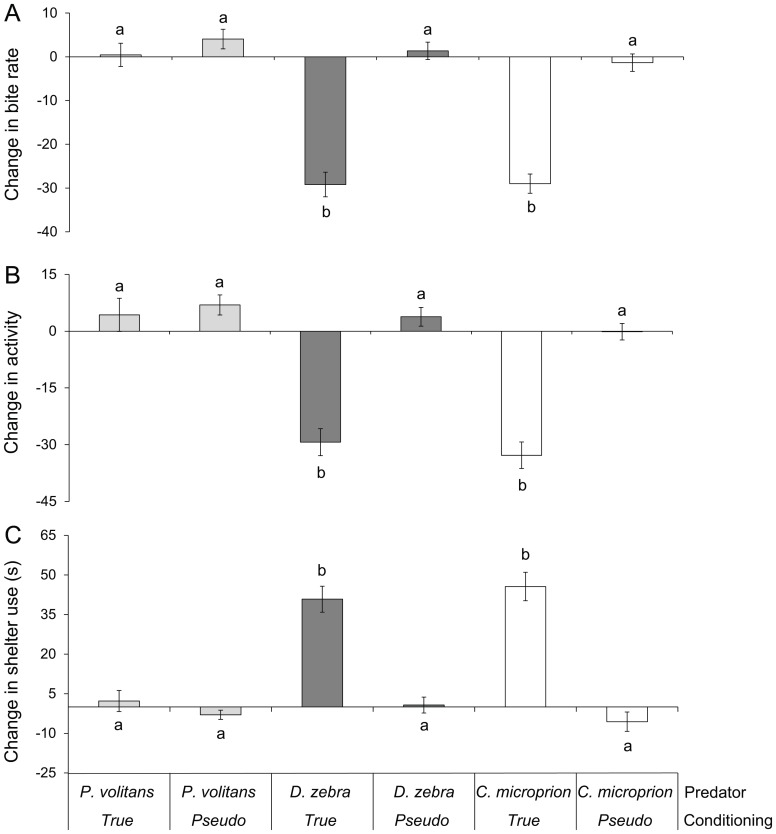
Behavioural responses of inexperienced and experienced juvenile Chromis viridis to olfactory cues of three different predators.Experienced prey fed less (A), lowered activity rates (B) and increased shelter use (C) when exposed to olfactory cues of Dendrochirus zebra and Cephalopholis microprion (N = 16–19). Letters indicate significant groupings.